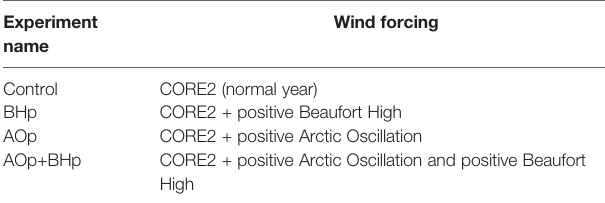
TABLE 1 | List of simulations used in Section